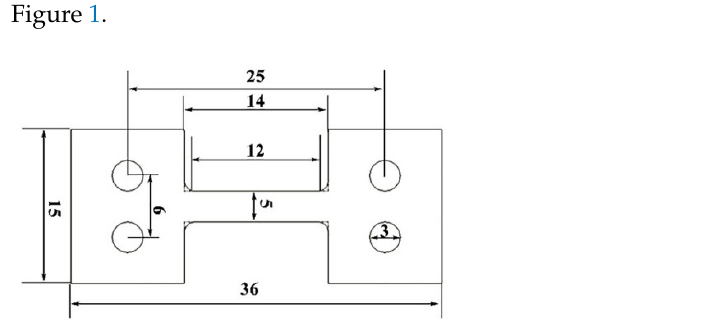
Figure 2. SEM (scanning electron microscope) micrographs of steel 1# under different solid solu- tion temperatures: ( a ) 650 °C, ( b ) 750 °C, ( c ) 800 °C, ( d ) 850 °C, ( e ) 900 °C and ( f ) 1050 °C. ( δ : δ - ferrite; γ : austenite.)